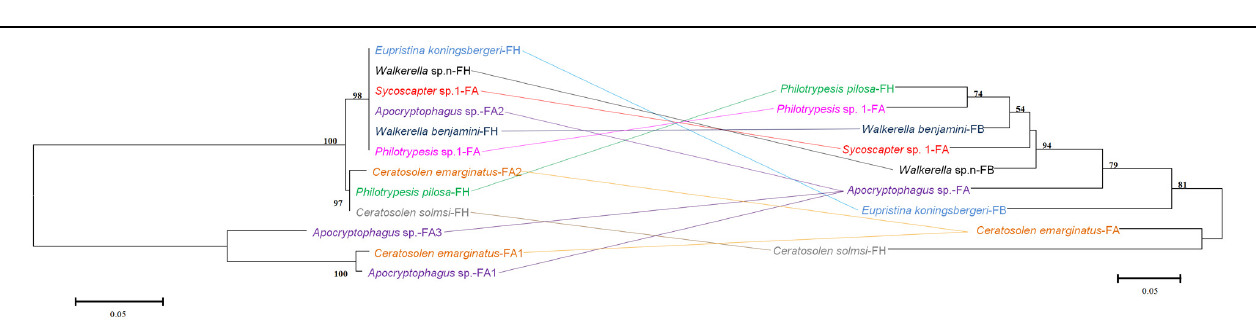
FIGURE 3 | Comparison between phylogenies of bacteriophage WO based on the orf7 sequence (right) and Wolbachia based on the wsp sequence (left). Samples tested in our survey are named by insect host name followed by the fig name (FA: Ficus auriculata, FH: Ficus hispida , FB: Ficus benjamina ) and haplotype numbers.